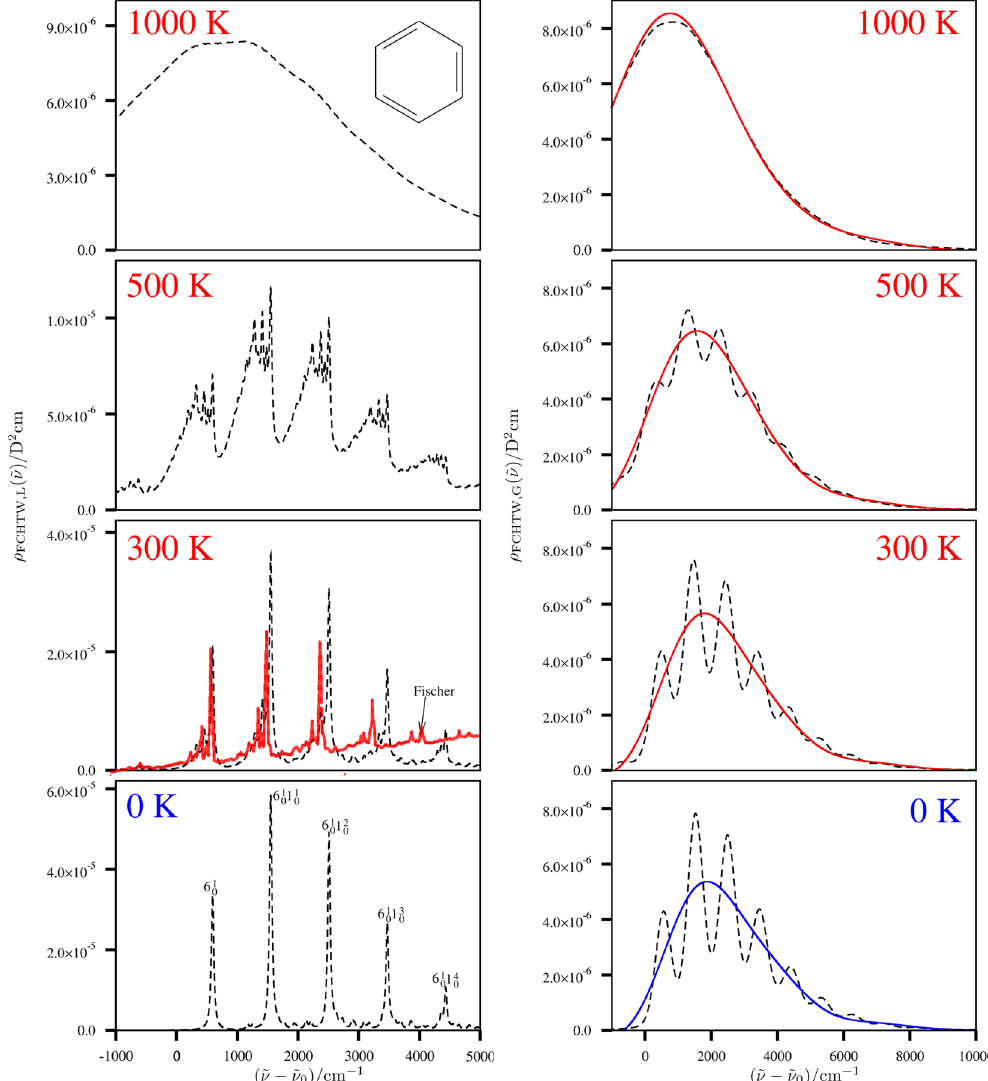
Figure 1. Left part of the figure: The dashed lines are drawn for the TCF-FFT approach with a Lorentzian line shape function with FWHM of 50 cm − 1 . A time increment Δ t of 0.51 fs and a grid with 2 16 grid points are used for the corresponding FFT calculations. The experimental UV absorption spectrum as reported by Fischer in ref. 37 is additionally shown in red, which has been adapted from ref. 37 and shifted to match approximately the position of the major peak in the region below the 0–0 transition wavenumber and rescaled to have similar peak height as the one computed for the 6 01 transition. Right part of the figure: The dashed lines are drawn for the TCF-FFT approach with a Gaussian line shape function of with FWHM of 500 cm − 1 . A time increment of 0.10 fs and a grid with 2 15 grid points are used for the corresponding FFT calculations. Solid lines are drawn for the curve obtained by Edgeworth expansion using up to 4-th order cumulants and, for 1000 K by Edgeworth expansion using up to 8-th order